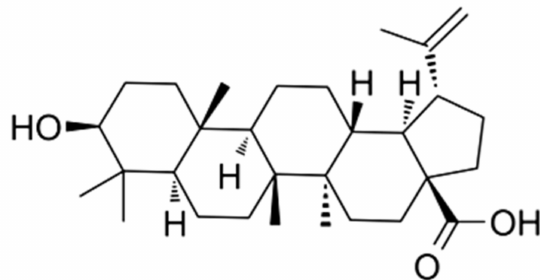
Figure 1. Chemical structure of betulinic acid